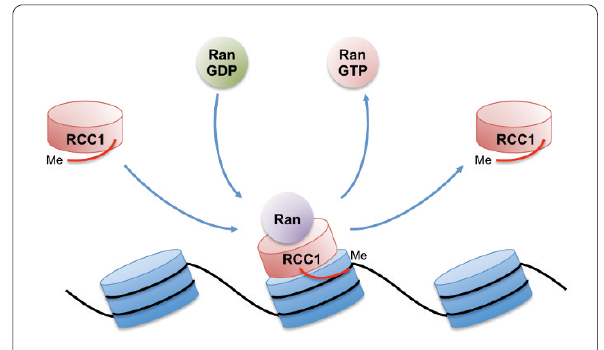
Figure 6 Model of the dynamic interaction of RCC1 with chroma- tin . RCC1 interacts weakly with a nucleosome through its core domain. Interaction of Ran-GDP releases GDP and leads to the transient forma- tion of a binary complex between apoRan and RCC1 in which the methylated N-terminal tail undergoes a conformational change that allows it to interact with DNA and stabilise the association of RCC1. Binding of GTP to Ran causes dissociation of the binary complex and the release of RCC1 from the